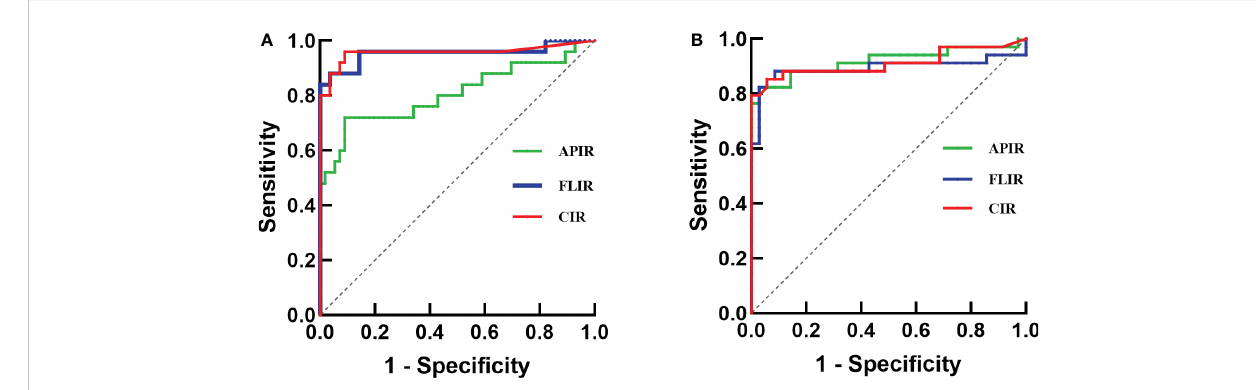
FIGURE 3 ROC curve analysis of APIR, FLIR and CIR. (A) Progressive collapse as an endpoint. (B) Terminal collapse as an